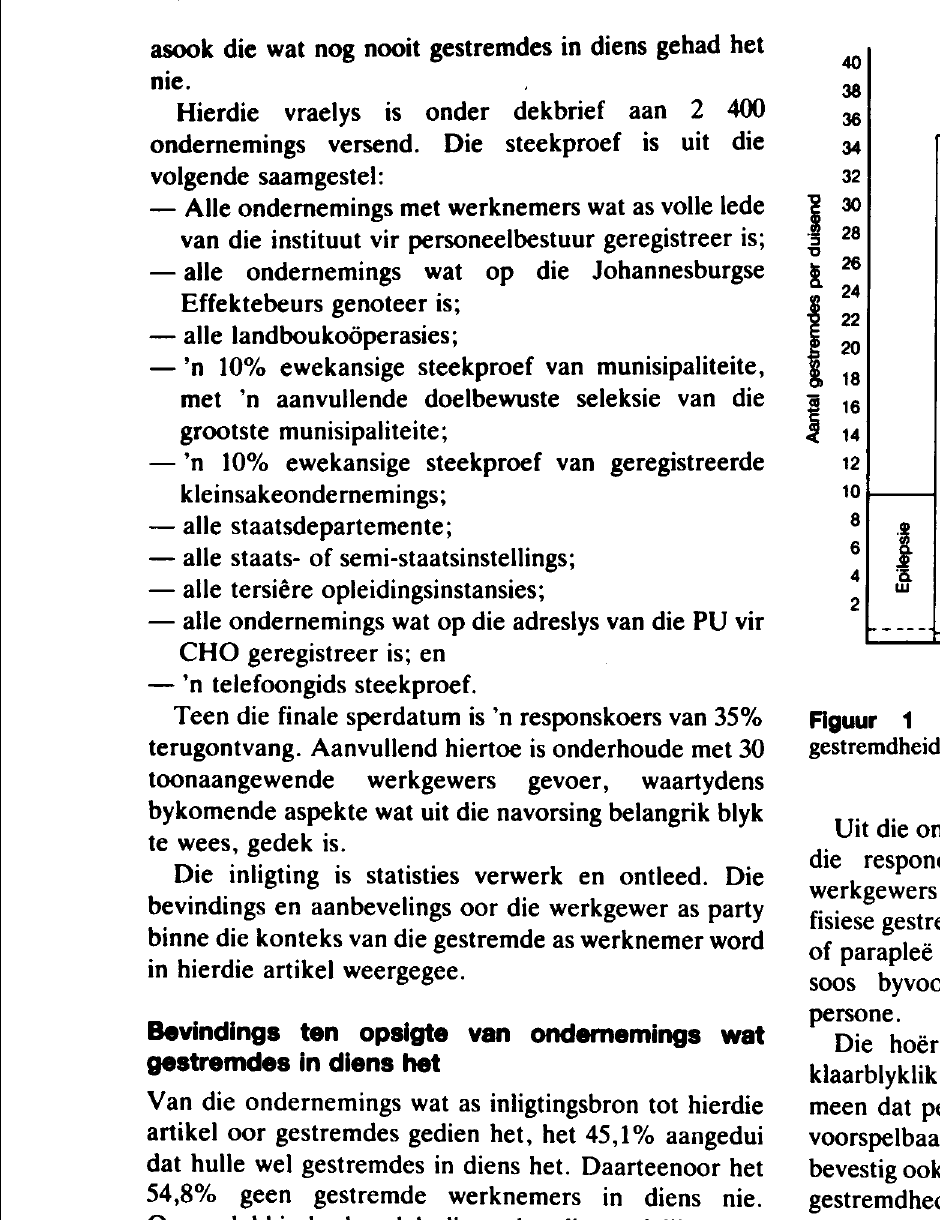
ontwikkel (Esterhuizen & Van der Burgh, 1982: 7). Die werkgewer se benadering tydens